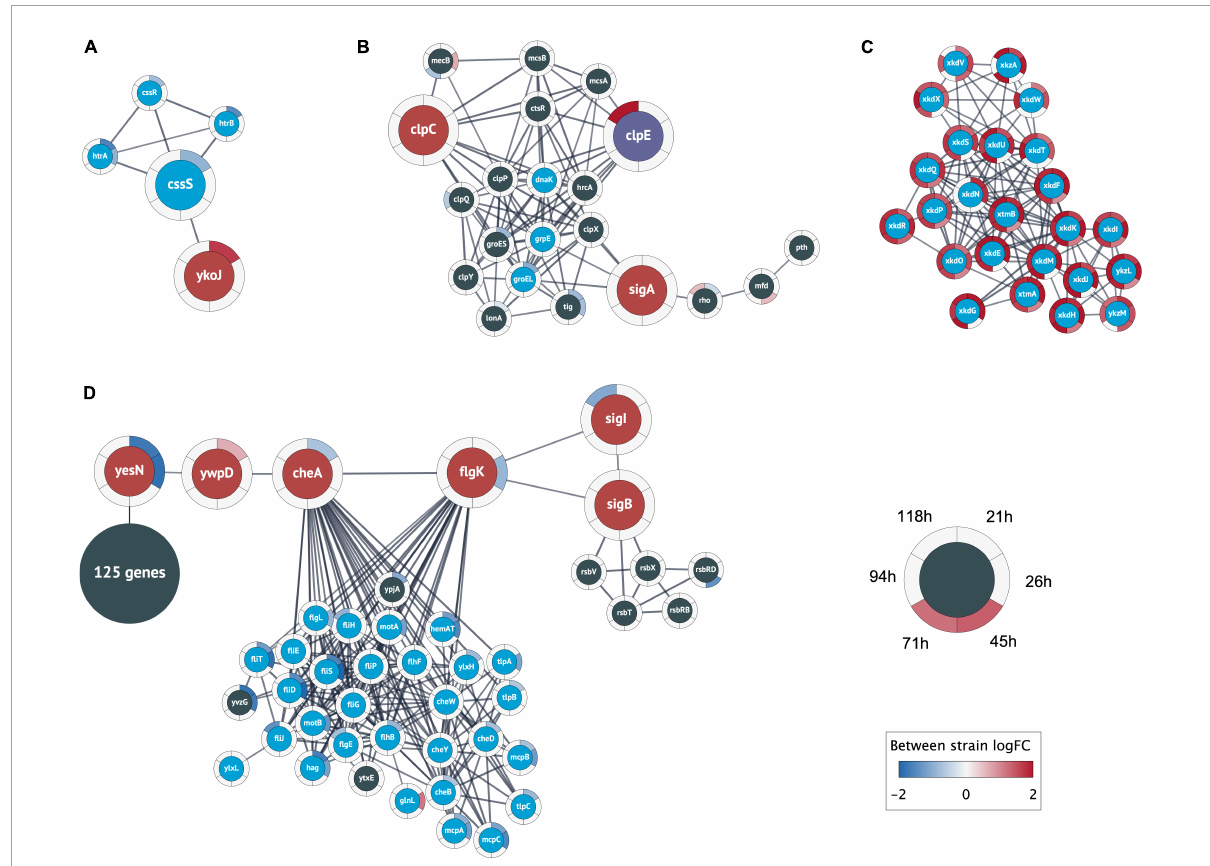
FIGURE4 Relevant clusters of differentially expressed genes. Nodes represent protein coding genes and edges correspond to high-confidence protein interactions retrieved from STRING. The differential expression between strains is shown as rings around the nodes, where each ring contains the logFC values for each time point comparison in a blue-white-red color gradient (see figure legend). A high positive logFC is colored red and indicates a significantly larger expression in the +prsA strain compared to the control. Non-significant differential expression is shown as 0 logFC (white). The logFC color gradient was truncated at ± 2. (A) The genes in this cluster include the central heat shock stress two-component system of CssRS and the proteases HtrAB (blue nodes). The cluster also contains the gene ykoJ of unknown function (red node) connected to the stress transducer CssS (large blue node). (B) This cluster contains the competence/heat shock switch protein ClpC (leftmost red node) and the universal sigma factor SigA (rightmost red node); SigA and ClpC share interactions with the tree heat shock proteins dnaK, grpE, and groEL (blue nodes). The cluster also contains ClpE (purple node) that had substantially higher expression in +prsA at timepoint 118 h (logFC ∼ 2.6). (C) The analysis found a cluster of 24 prophage or prophage-like genes that were closely interacting and had significantly higher expression in +prsA throughout the fermentation. (D) The largest cluster contains a “bottleneck” of high-confidence interactions at two genes of unknown function (yesN and ywqD) between 125 genes of various catalytic function (summarized as one node) and 29 chemotaxis genes (blue